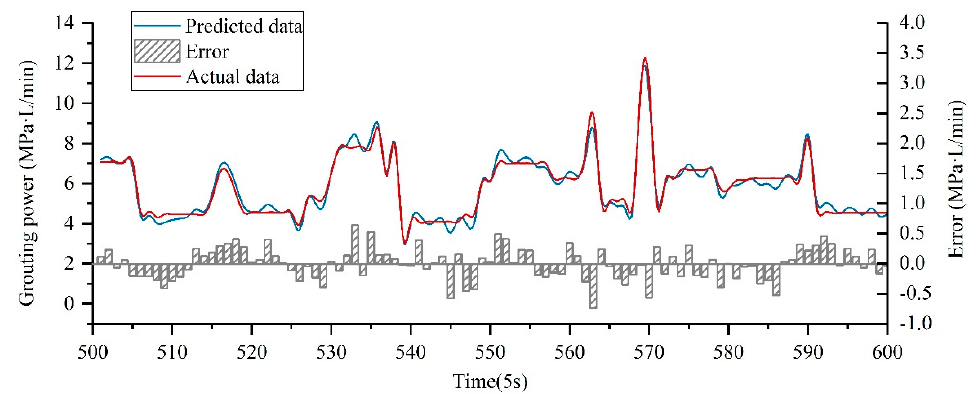
Figure 7. The PACFs of the original series and the subseries decomposed by EWT.